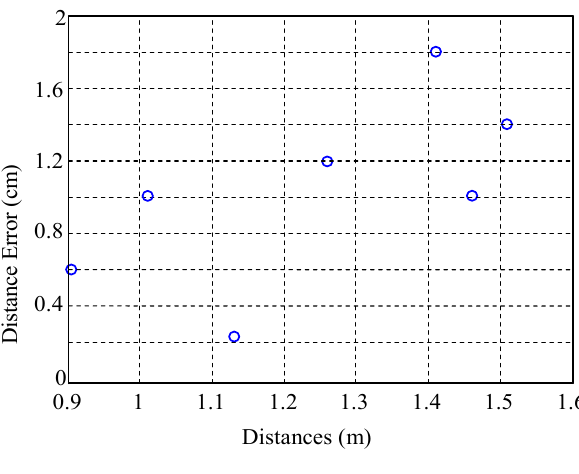
Figure 8. Relative distance error estimated in presence of